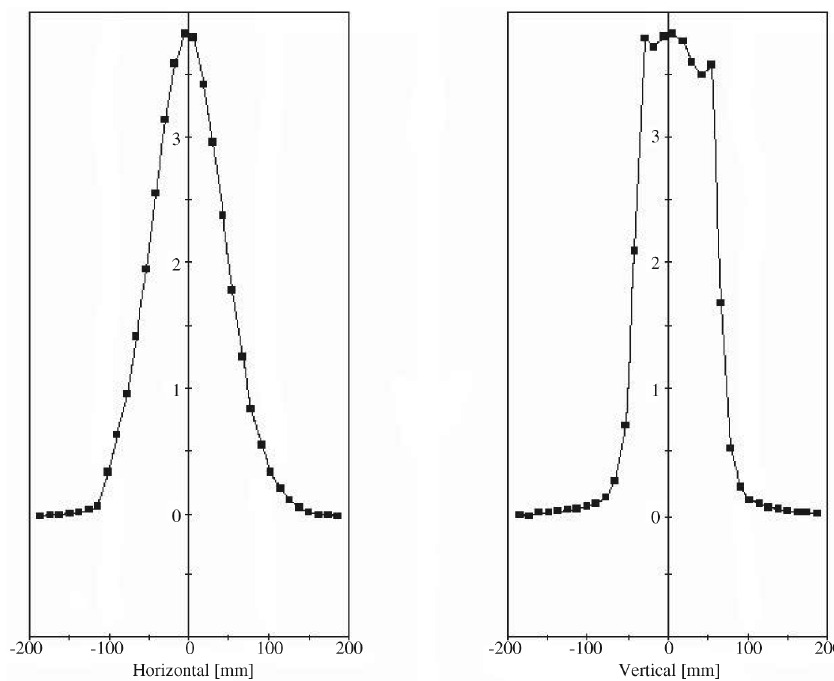
FIG. 12. Horizontal and vertical beam profiles at the target location of the NSRL line with only the vertical octupole (O2) ON. Note that only the vertical profile is affected by the octupole (O2), with the horizontal profile remaining unaffected keeping a Gaussian shape.